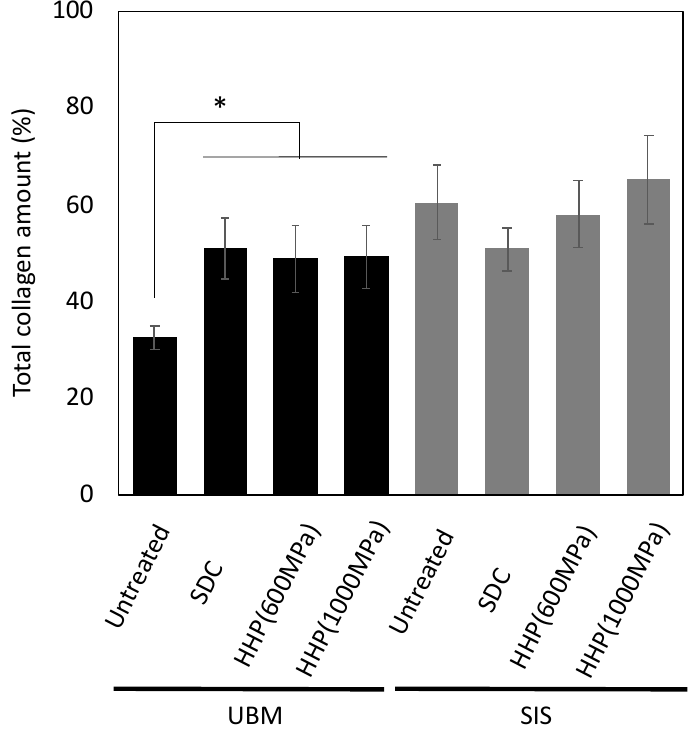
Figure 2. Quantitative analysis of total collagen in decellularized tissue. * p < 0.005. SDC and HHP represent the method of decellularization of each tissue (urinary bladder matrix (UBM) and small intestine submucosa (SIS)).